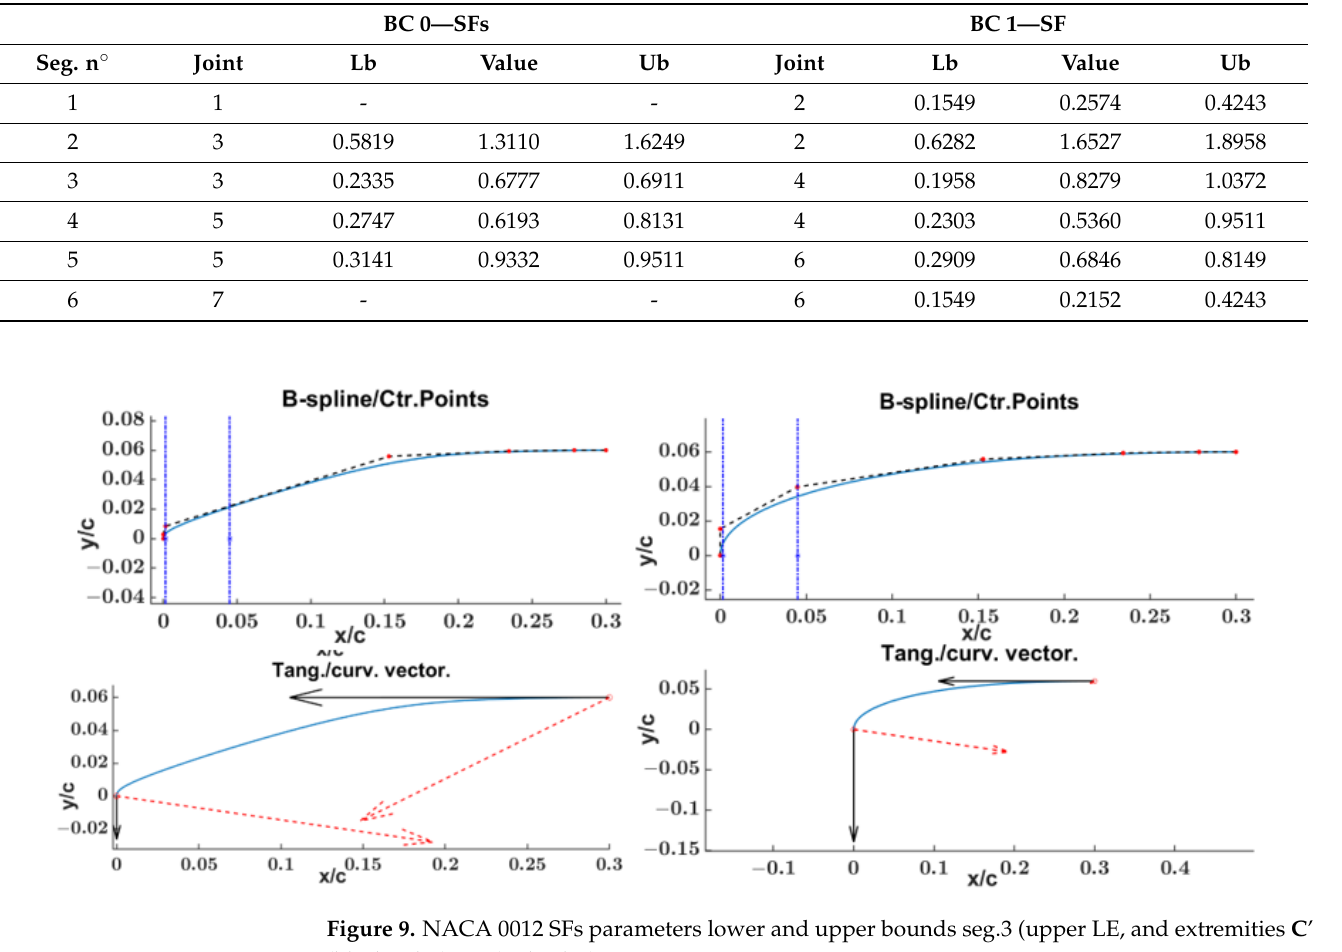
Table 6. Segment-wise evaluated SFs.